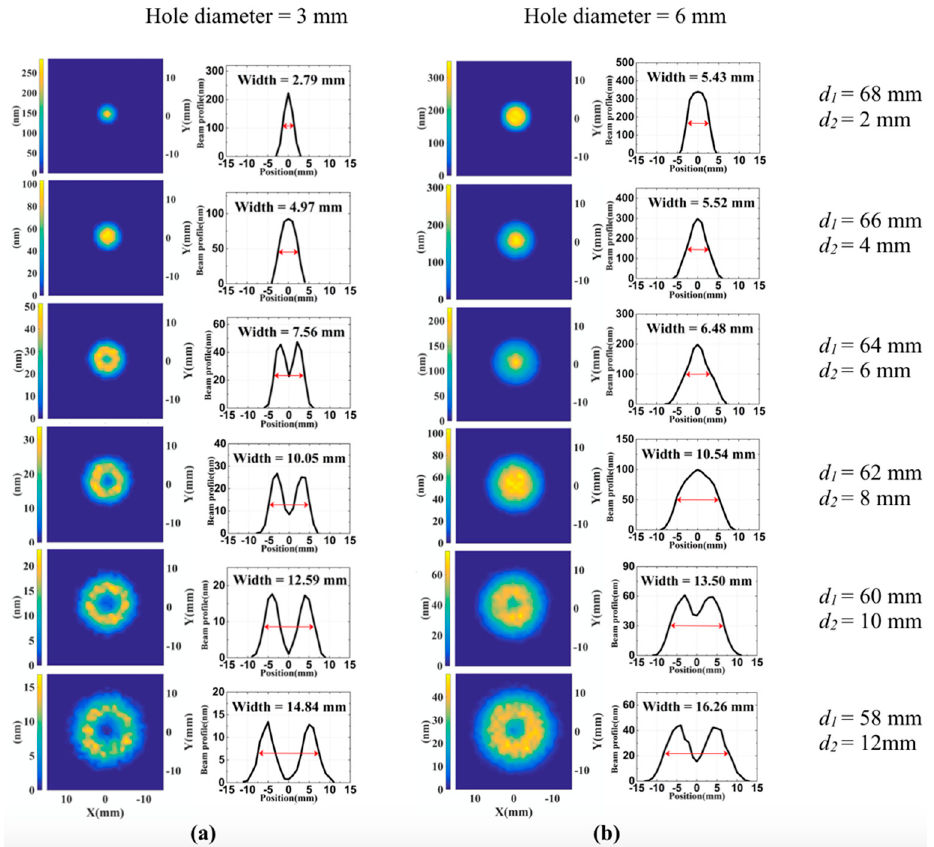
Figure 10. Simulation results of the particle distribution contour on the substrate with different distances between the mask and substrate. ( a ) Hole diameter of 3 mm. ( b ) Hole diameter of 6 mm.